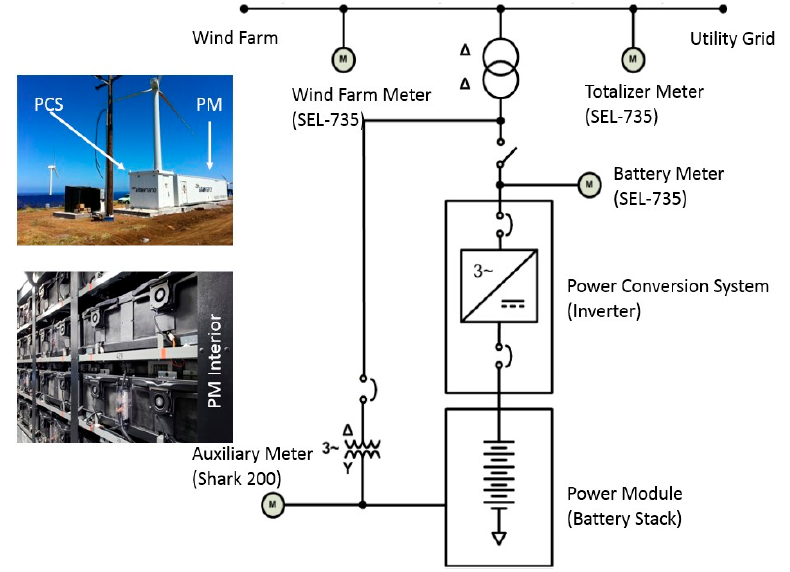
Figure 2. Schematic of the Hawaii island BESS highlighting metering units. The pictures insets show the installed PM and PCS units on site (top), and the line replaceable units (LRUs) which house the battery cells within the PM (below).